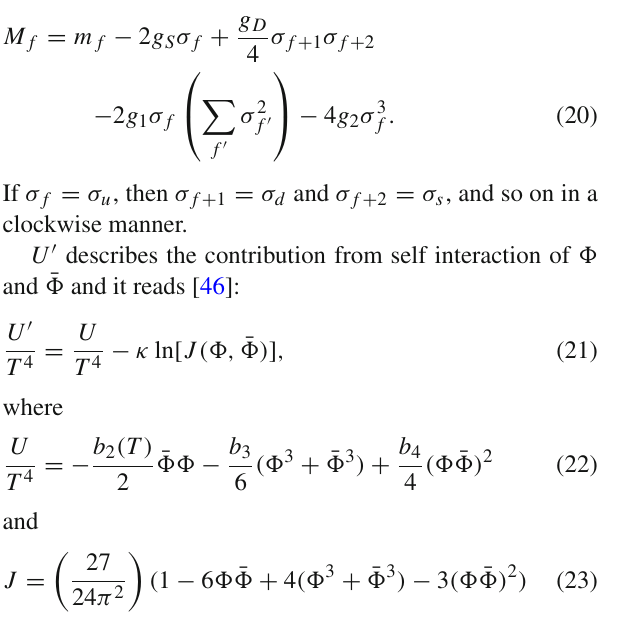
Fig. 8 The kurtosis of baryon number fluctuation κσ 2 in the realistic PNJL model as a function of the temperature at zero baryon number χ = 166MeV. κσ 2 = 1 in the hadron resonance gas density with T 0 (HRG) limit and κσ 2 (cid:5) 0 . 068 in the ideal free quark gas (FQG) limit